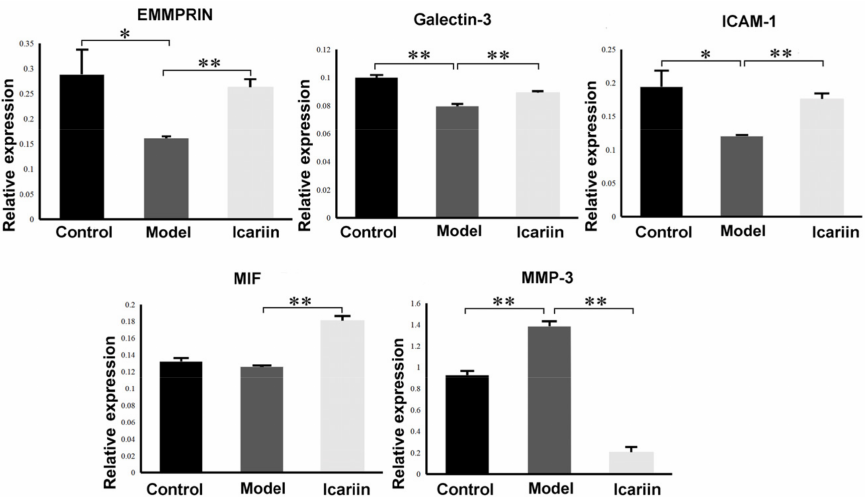
Figure 4. Relative expression level of five proteins identified by Elisa assay. Data analysis was performed using t -test analysis and ANOVA, error bars indicate standard deviation, and ** means p < 0.01, * means p <